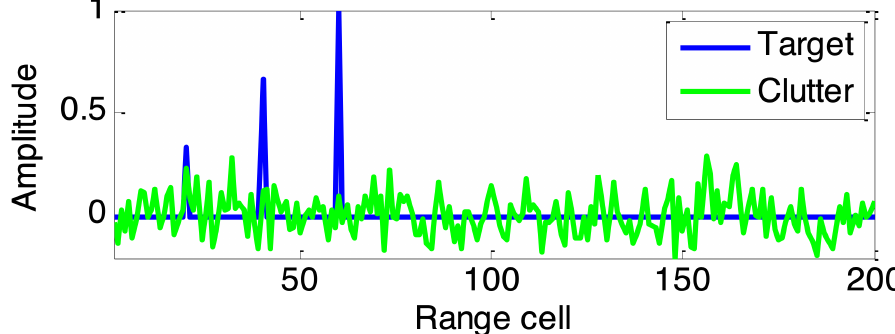
Figure 3. The impulse responses of the extended target and sea clutter.